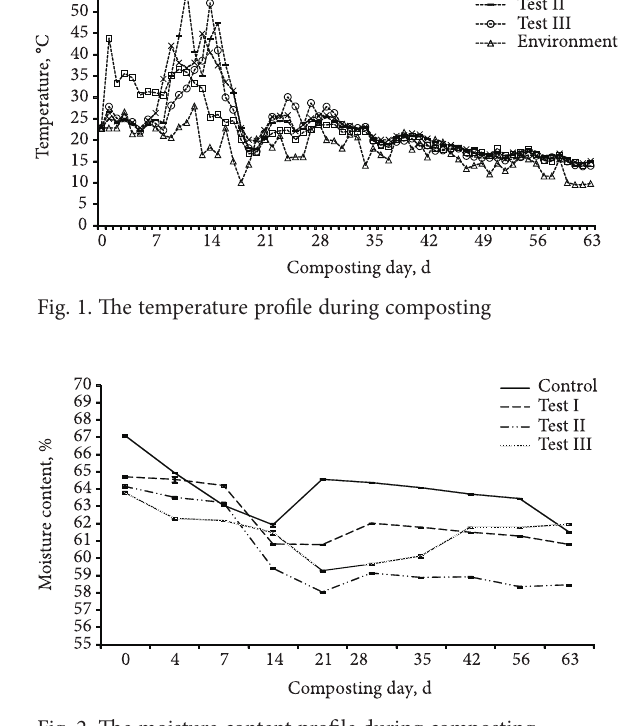
Fig. 2. The moisture content profile during composting